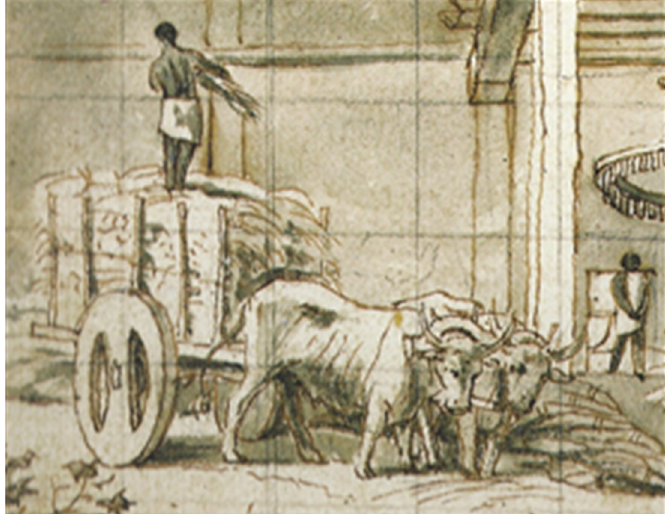
Figure 21. Brazilian cattle Sugar Mill , Frans Post, detail, 1640 (Royal Museum of Fine Arts,